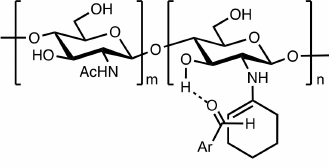
Figure 40. The proposed transition state for the addition of cyclohexanone to 4-nitrobenzaldehyde to give the anti aldol.